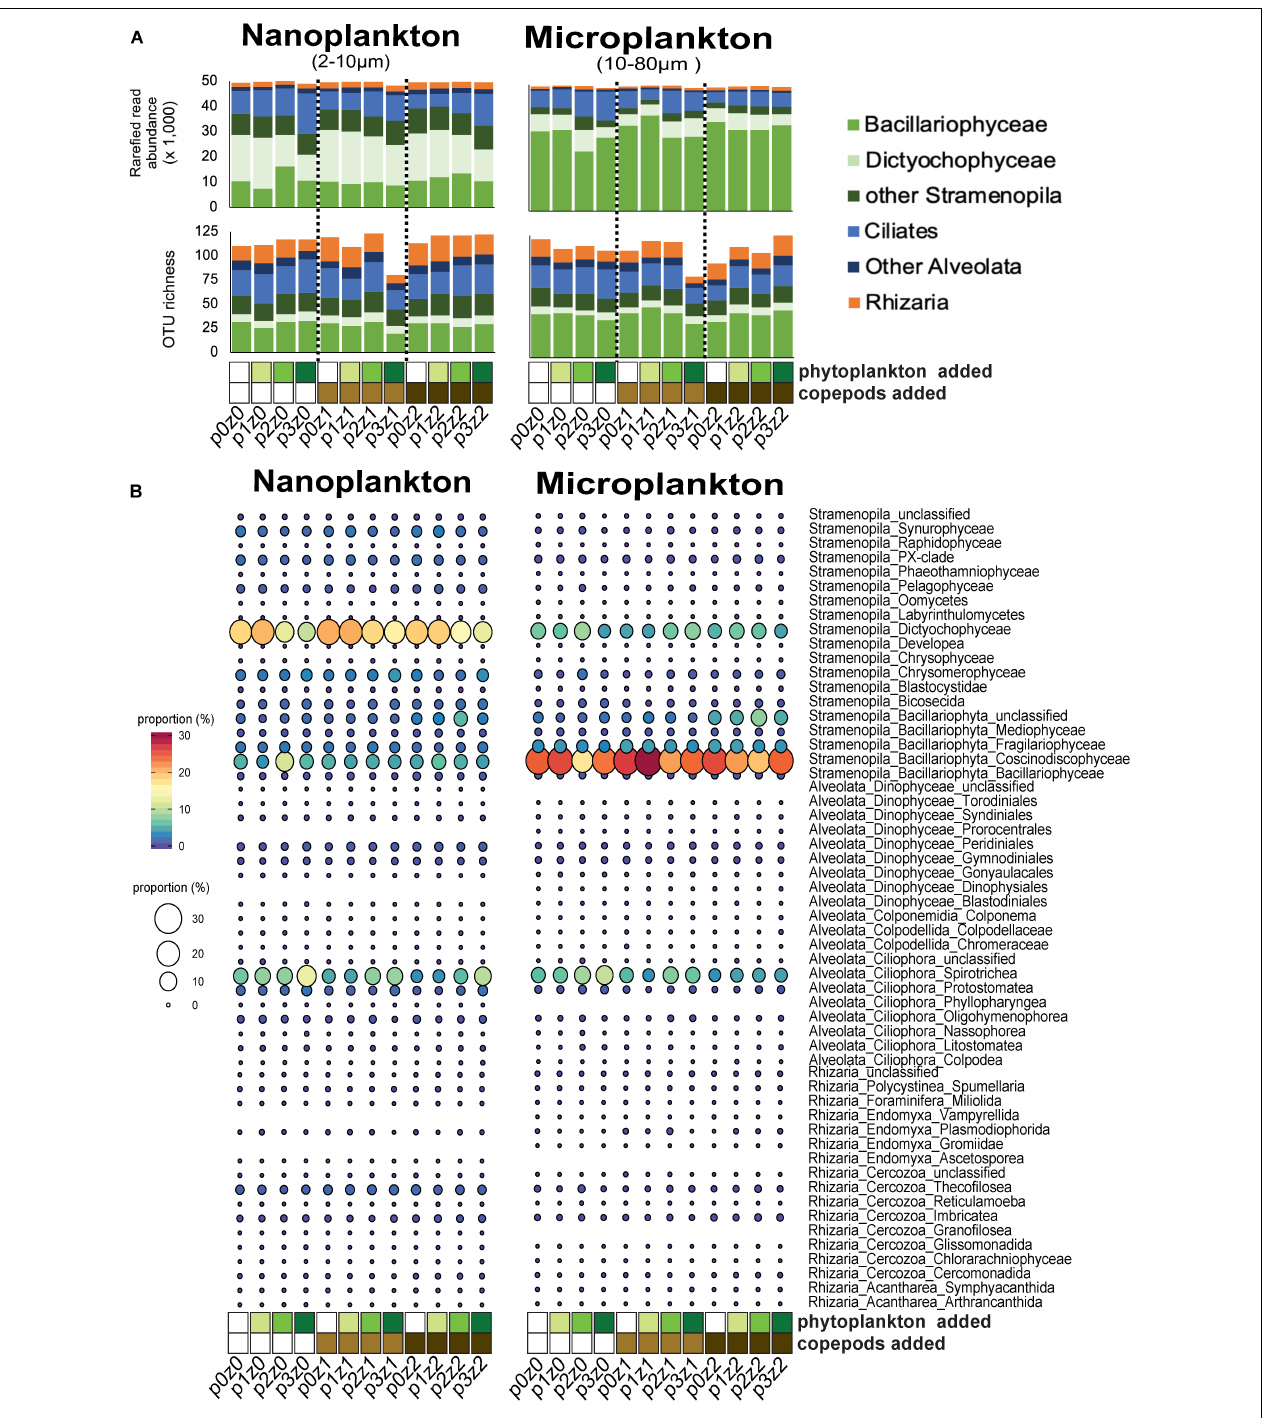
FIGURE 1 | Comparison of community composition based on amplicon analyses (A,B) across treatments within our microcosms. (A) Read and abundant OTU ( > 10 reads) distributions of SAR (Stramenopila, Alveolata, and Rhizaria) lineages within each treatment show a dominance in different stramenopiles lineages by size fraction (Dictyochophyceae in the nanosize and Bacillaryophyceae in the microsize) and also an high proportion of ciliates and other SAR lineages in both sizes. (B) Proportions of reads at a “family-level” show an increase of spirotrich ciliates with phytoplankton bloom. For all panels, the letter “p” in the sample label represents the abundance of phytoplankton added: none for p0 (white), 5 · 10 2 cells mL - 1 for p1 (yellow–green); 5 · 10 3 cells mL - 1 for p2 (light green), and 5 · 10 4 cells mL - 1 in final concentration for p3 (green). The letter “z” in the label represents the number of copepods added: none for z0 (white), 5 per liter for z1 (light brown), and 10 per liter for z2 (dark brown). For example, p0z0 has no copepods and no phytoplankton added and represents our control; p3z0 was incubated without copepods but in phytoplankton bloom condition.